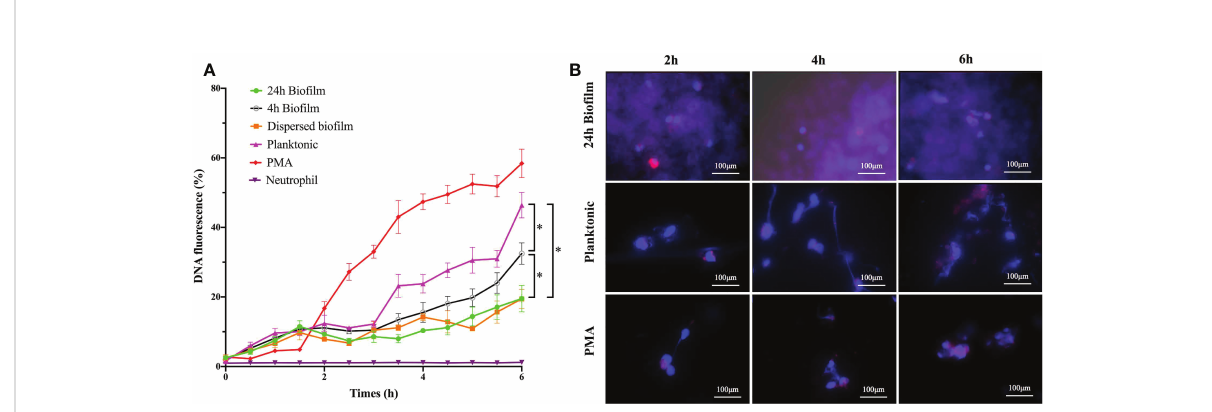
FIGURE 2 The shifting of NETs formation over the whole bacterial lifespan was time-dependent. (A) Kinetics of NETs release to different lifestyles of S. mutans (4h-bio fi m, 24h-bio fi lm, dispersed bio fi lm and planktonic) and PMA positive control during 6h co-culture period. NETs releases were quanti fi ed with a Sytox Green fl uorescence assay. Neutrophils alone was served as the negative control. Data were presented as percentage of DNA fl uorescence compared with a TritonX-100 lysis control (100%). Compared with the PMA positive stimuli, planktonic S. mutans generated high fl uorescence, indicating NETs formation. In contrast, the 24-h bio fi lm and dispersed bio fi lm did not produce fl uorescence. Besides, 4-h pre-mature bio fi lm did elicit NETs at a level lower than planktonic but higher than the mature bio fi lm. Data were depicted as mean ± SD (n=6). Statistical analysis was performed using a one-way ANOVA following Bonferroni multiple comparisons post-hoc test with p <0.05. *p<0.05 (B) Kinetics of NETs release visualized by immuno fl uorescence imaging. Neutrophils were stimulated with PMA, planktonic, and bio fi lm S. mutans for 2h, 4h and 6h respectively. As indicated by immuno fl uorescence staining, planktonic S. mutans elicited more NETs release with increasing co-culture time. The pattern of NETs release to planktonic S. mutans paralleled that of positive PMA stimulation. Staining of NE was barely observed even after 6 h of co-culture with the S. mutans bio fi lm. (scale bar: 100 m